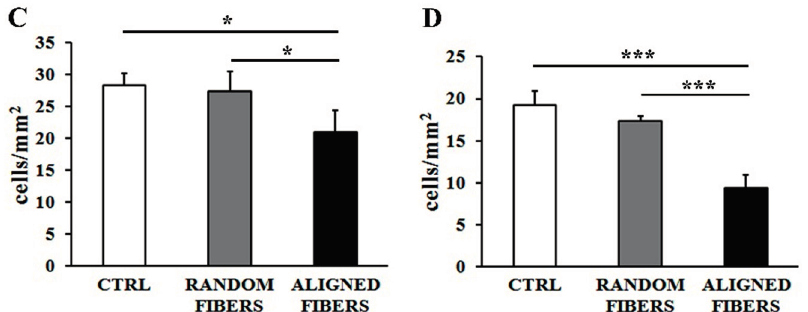
Figure 2. Adhesion assay: Confocal images (63× magnification) after DAPI (blue), tetramethylrhodamine (TRITC)-conjugated phalloidin (red) and vinculin (green) staining of RT4-D6P2T ( A ) and primary SC ( B ) on poly- L -lysine coated coverslips (control condition), random fibers and aligned fibers 3 h after seeding. Scale bar: 40 μ m; RT4-D6P2T ( C ) and primary SC ( D ) cell numbers were expressed as cells/mm 2 ± standard error of the